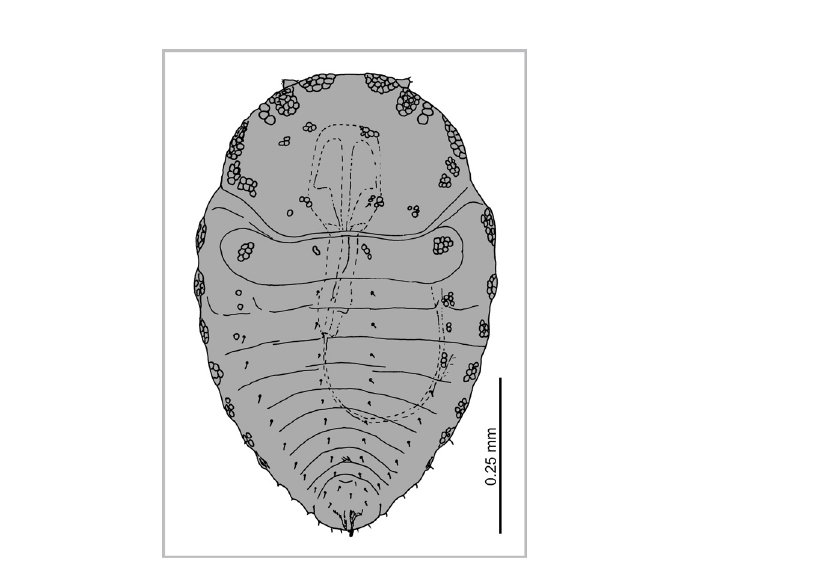
Fig. 1. Pineus (Pineus) pineoides (Cholodkovsky, 1907). Adult aptera (after Schneider-Orelli 1940, modified).